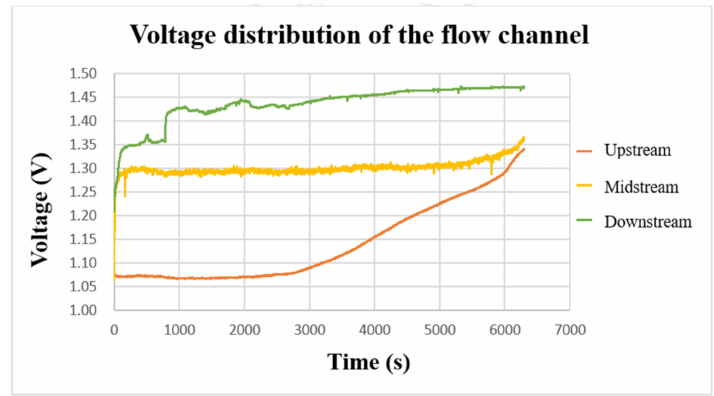
Figure 15. The charging-voltage curve of the flow